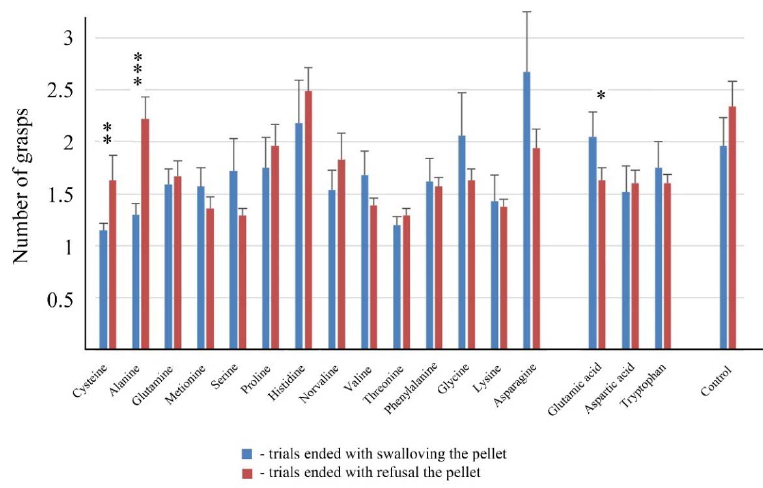
Figure 8. The number of grasps of pellets flavored with amino acids ended with swallowing or refusal of the pellet by barramundi Lates calcarifer . *, ** and ***—differences between trials performed with each amino acid are significant at p < 0.05, p < 0.01, and p < 0.001, respectively (Mann–Whitney U ‐ test). Whiskers are the s.e.m.